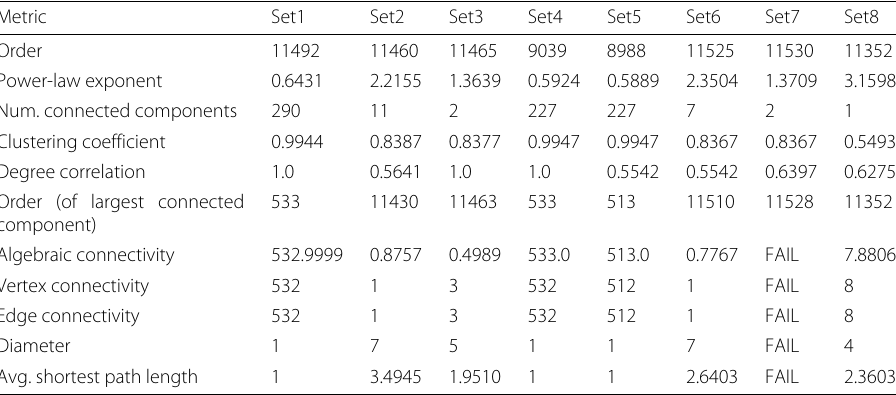
saw earlier that noise in real-world networks can have a ‘weak link’ effect in that